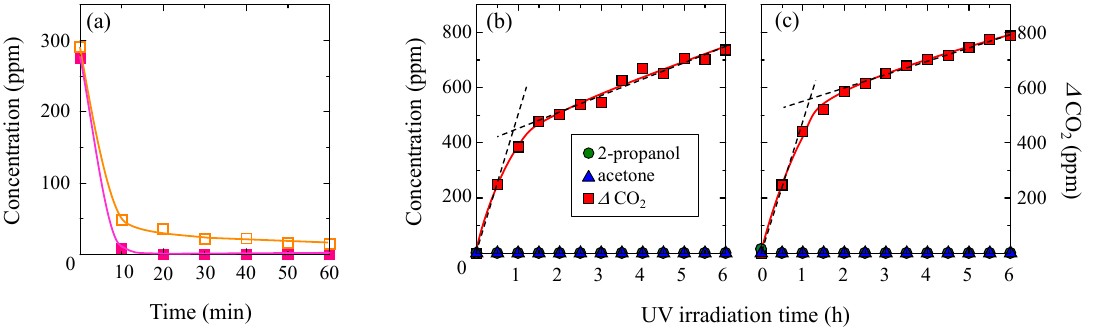
Figure 8. ( a ) Temporal concentration changes of 2-propanol during the dark storage of TiO 2 -coated porous glass cloth in gaseous 2-propanol with 2-mg/L water content (closed squares) and 18-mg/L water content (open squares). ( b , c ) The concentration changes of 2-propanol, acetone, and CO 2 during UV irradiation of the TiO 2 -coated non-porous glass cloth in gaseous 2-propanol with 2-mg/L and 18-mg/L water contents, respectively. All the experiments were conducted at 35 °C.